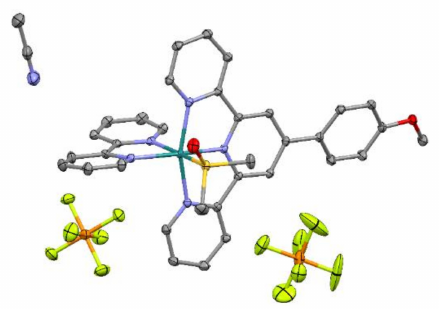
Figure 6. Asymmetric unit for [RuT1B0(DMSO (S) )](PF 6 ) 2 · CH 3 CN. Displacement ellipsoids are drawn at the 50% probability level. Hydrogen atoms are omitted for